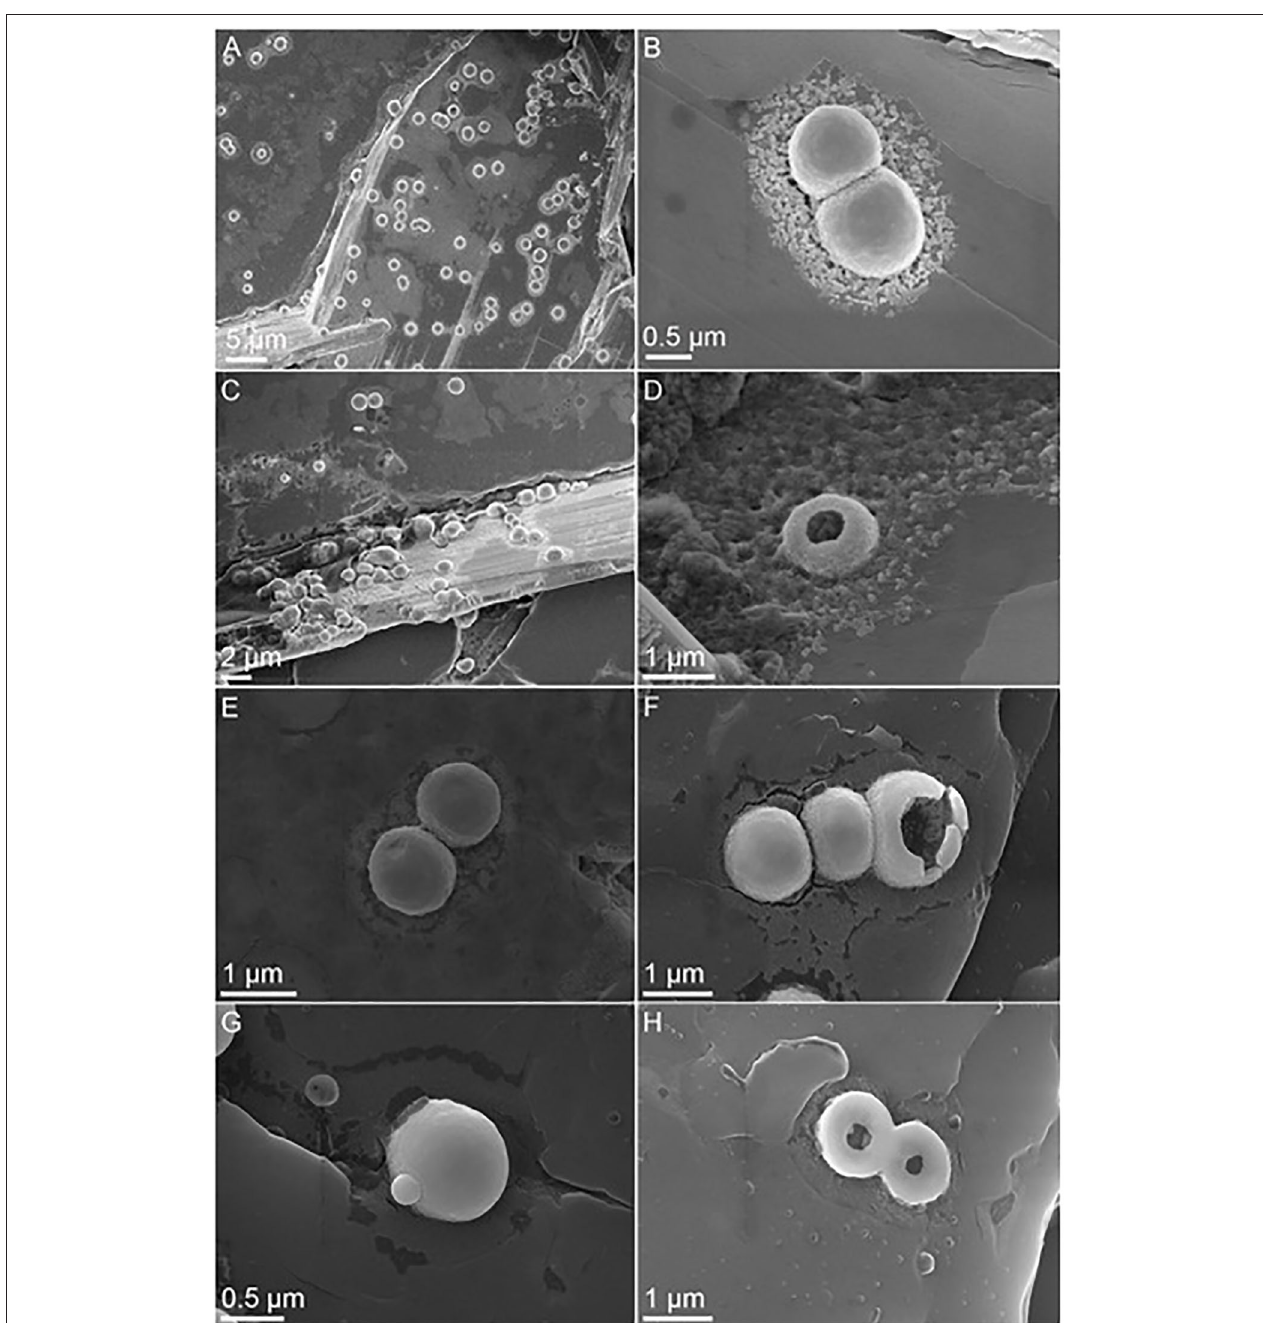
FIGURE 1 | Scanning electron microscopy (SEM) images of desiccated M. sedula cells grown on tungsten (W) ore scheelite and preserved after 2 months of dehydration. (A,C) SEM images of dehydrated colonies of M. sedula cells grown on scheelite. (B) Magnified SEM image showing single scheelite-grown cells of M. sedula preserved after dehydration. (D–H) SEM images of intact cells of M. sedula maintaining the integrity after dehydration and broken dried cells of M. sedula revealing their cellular interior.